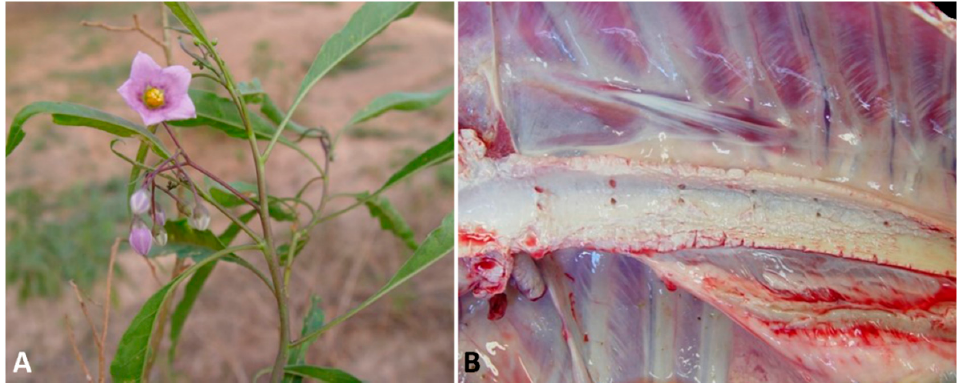
Figure 3. Calcinogenic glycoside-containing plant poisoning. ( A ) Solanum malacoxylon plant. ( B ) Aorta, sheep. Mineralization due to Solanum malacoxylon intoxication (Photos courtesy of Dr. Edson Moleta Colodel).